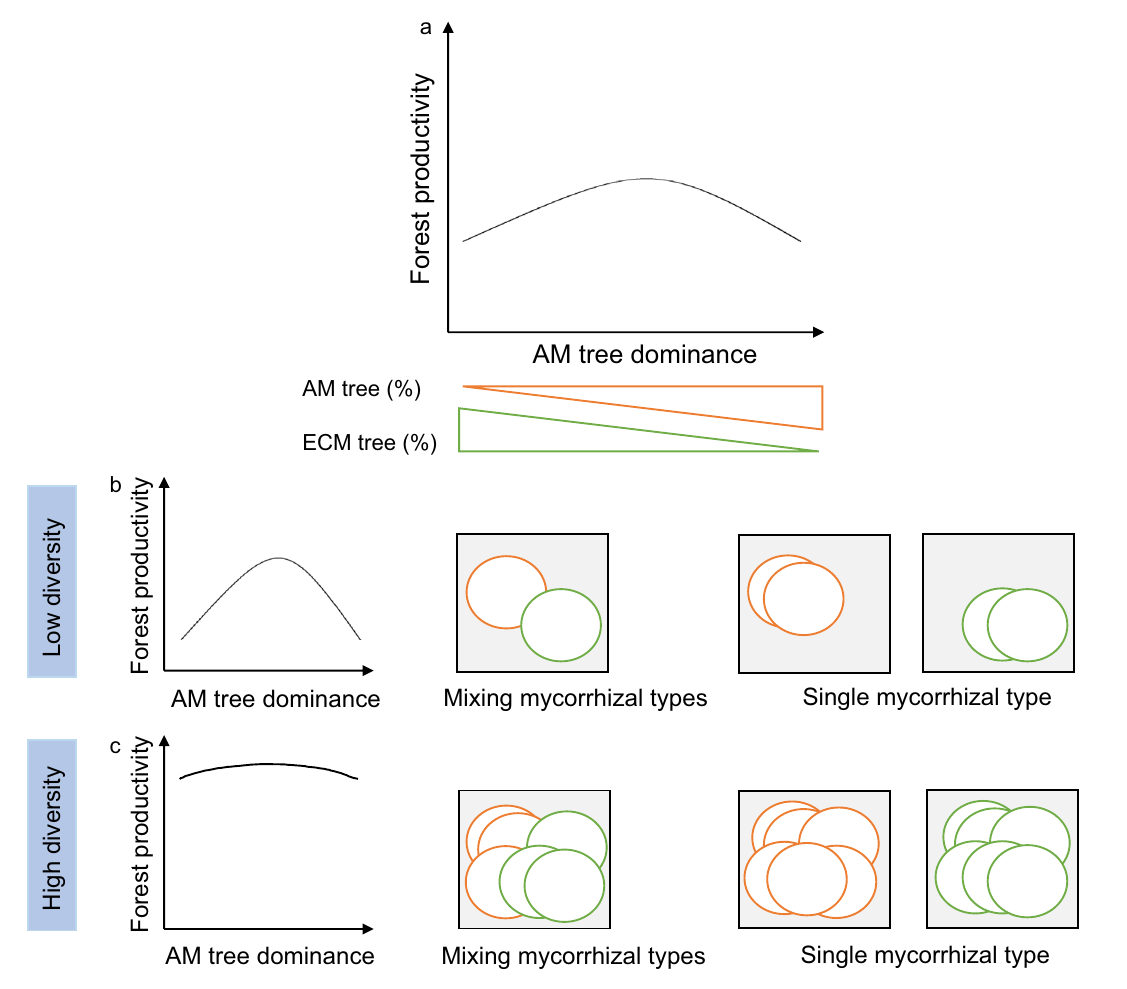
Fig. 1 | Conceptual fi gure illustrating the hypothetical relationships between AMtreedominanceandforestproductivity,aswellastheunderlyingresource- use scenarios in tree species that coexist in local communities. a Hypothetical overall relationship. b Hypothetical relationship at low tree species diversity. c Hypothetical relationship at high tree species diversity. We expect a concave- negative relationship between AM tree dominance and forest productivity, which would be more evident at low than at high tree species diversity. At low diversity, weexpectthatproductivitywouldbehigherincommunitieswithbothmycorrhizal typesthaninthosedominatedbyasinglemycorrhizaltype,becausethelargeniche differences between AM and ECM tree species would maximize the occupied resource space. At high diversity, we expect that resource space would be well